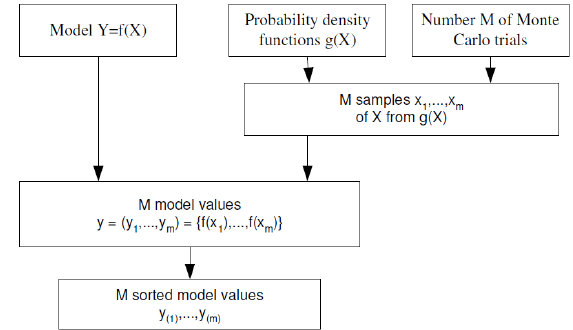
Figure 1 . Workflow of the Monte Carlo simulation (Cox et al.,